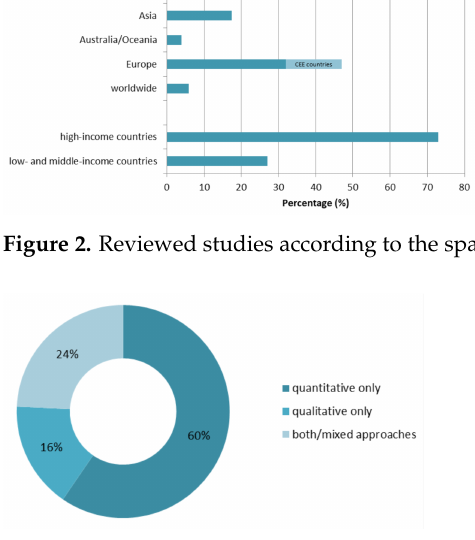
Figure 3. Reviewed studies according to the methods used. Table 2. Key themes and sub-themes identified across the set of reviewed studies. Key Themes/Issues of Concern